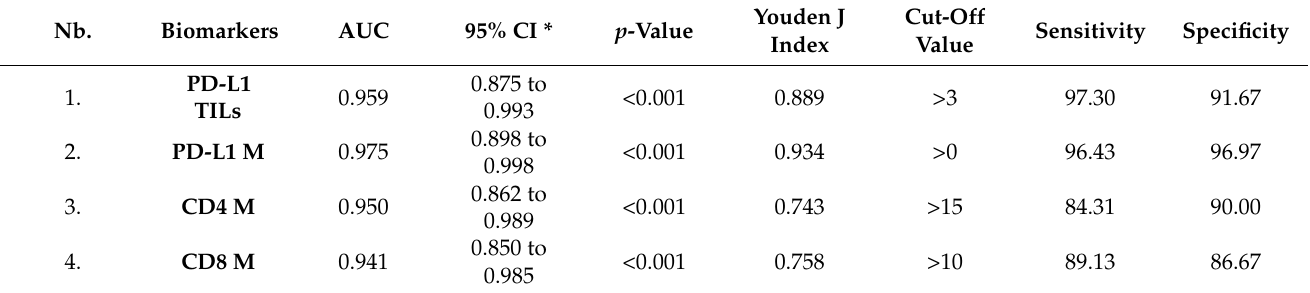
Table 3. Receiver operating characteristic (ROC) analysis of PD-L1, CD4, and CD8 tumor-infiltrating lymphocyte biomarkers in melanoma patients.